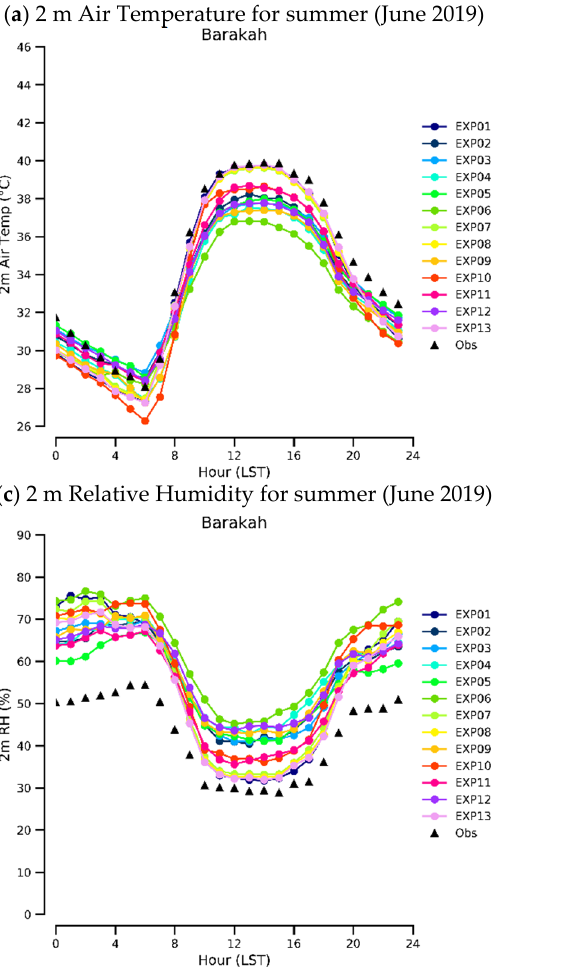
Figure 7. Mean diurnal variations for 2 m air temperature and relative humidity at Barakah station calculated for June and January 2019. The curve in black color shows the observation, while the others depict the different model simulations.